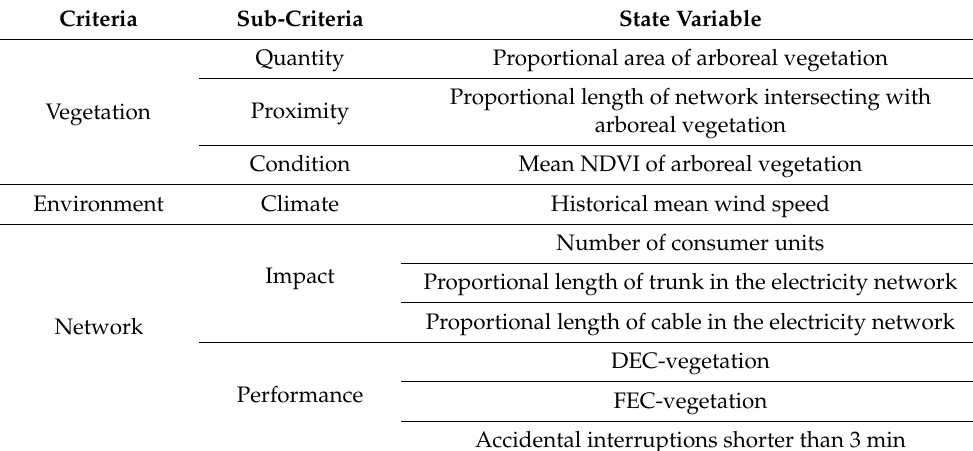
Table 3. Criteria, sub-criteria, and state variables defined to prioritize tree pruning in urban areas.